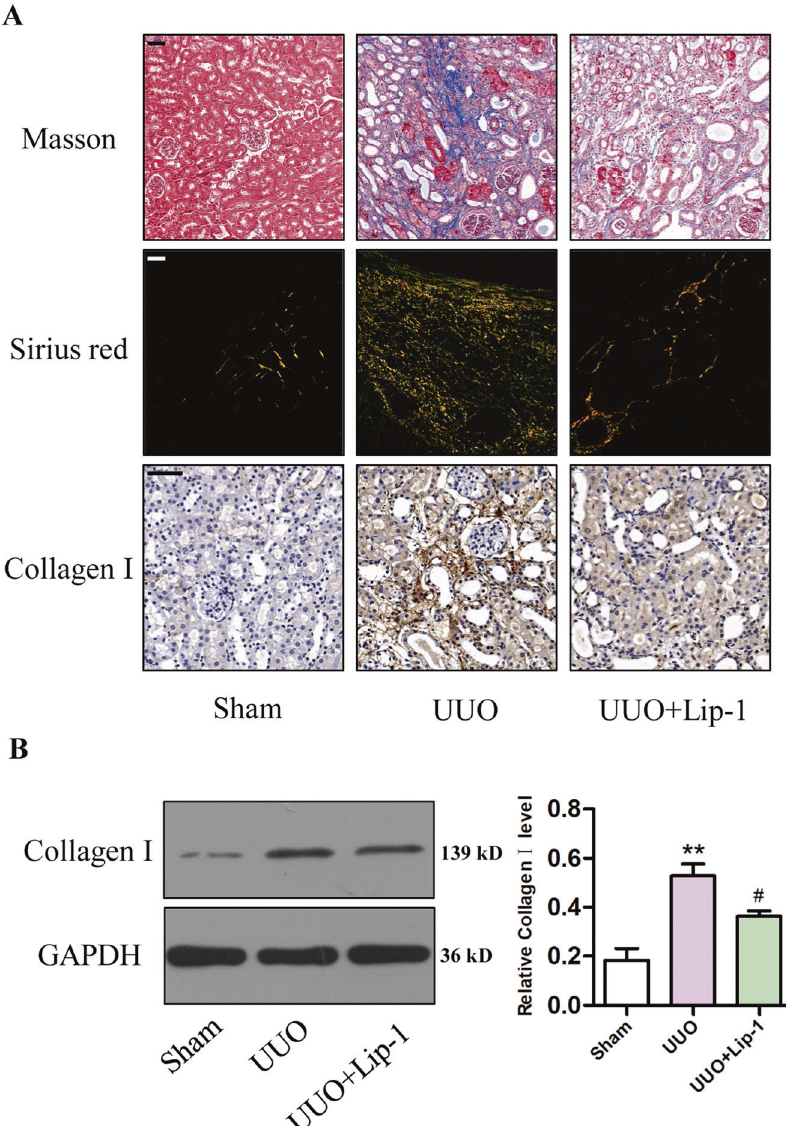
Fig. 3 Effects of Liproxstatin-1 on collagen deposition in the UUO model. A Renal fi brosis was evaluated by Masson ’ s trichrome staining (bar = 50 μ m), Sirius red staining (bar = 50 μ m), and immunohistochemical staining of collagen I (bar = 50 μ m). B Protein expression of collagen I in renal tissues of mice detected by western blotting ( n = 3, ** P < 0.01 vs sham group; # P < 0.05 vs UUO group). The data are presented as the mean ±